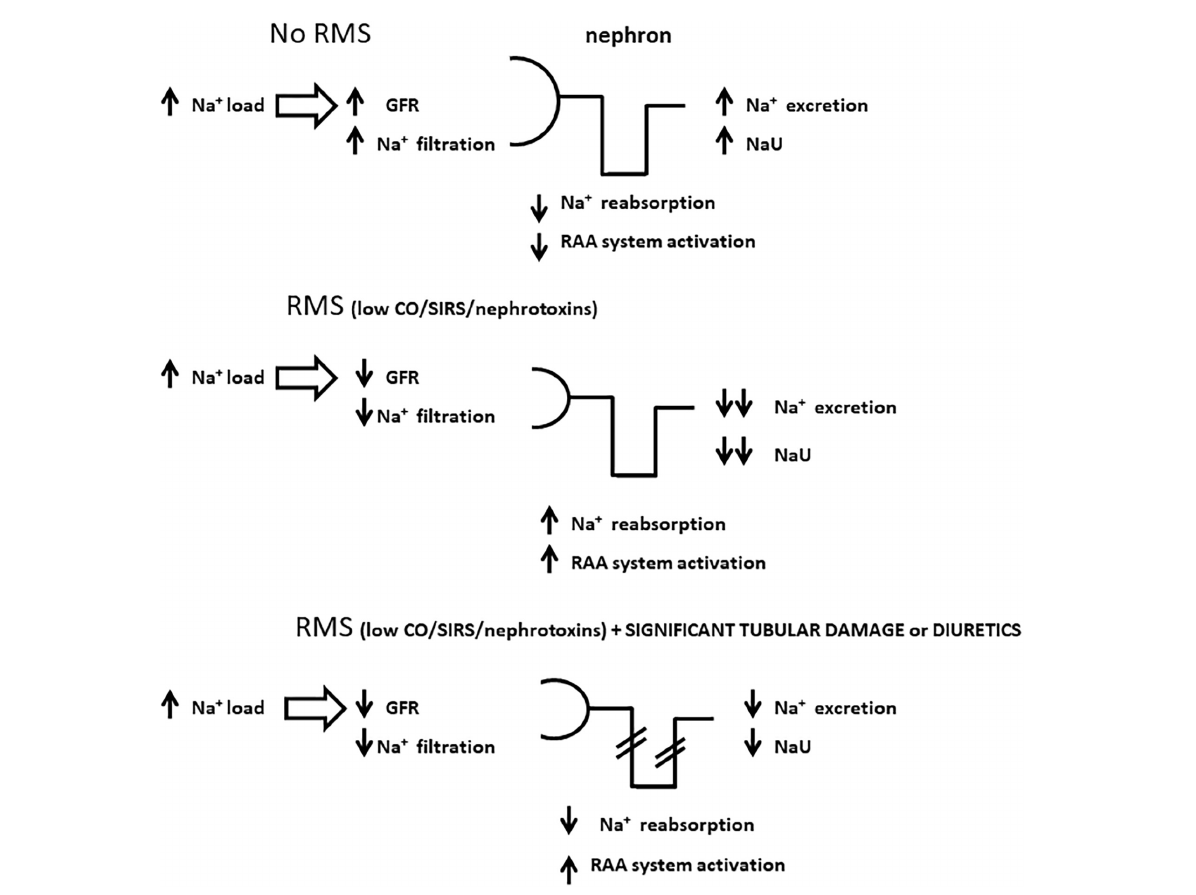
FIGURE1 Schematic representations of sodium handling by the nephron in distinct scenarios with high sodium load, a condition frequently seen in critically ill patients. Panel (A) represents a state with no renal microcirculatory stress (RMS) where high sodium load generates high urine sodium concentration (NaU), commonly above serum sodium concentration; panel (B) illustrates how sodium accumulates in the body in the setting of RMS due to a combination of low sodium filtration and avid sodium tubular reabsorption, which may lead to very low NaU levels; panel (C) represents a similar scheme to panel (B) except for significant tubular damage and/or the administration of diuretics, both of which jeopardize sodium tubular reabsorption. In this case, NaU levels are also depleted, comparatively higher to panel (B) , but not as high as in panel (A) due to lower sodium filtration. GFR, glomerular filtration rate; RAA, renin-angiotensin-aldosterone; CO, cardiac output; SIRS, systemic inflammatory response